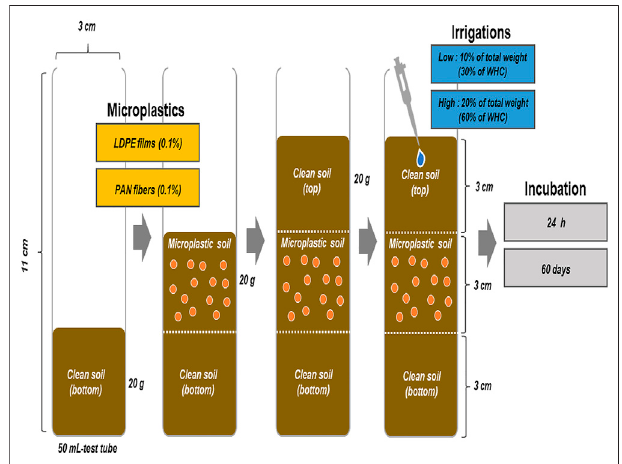
FIGURE 1 | The diagram of the soil column test in this